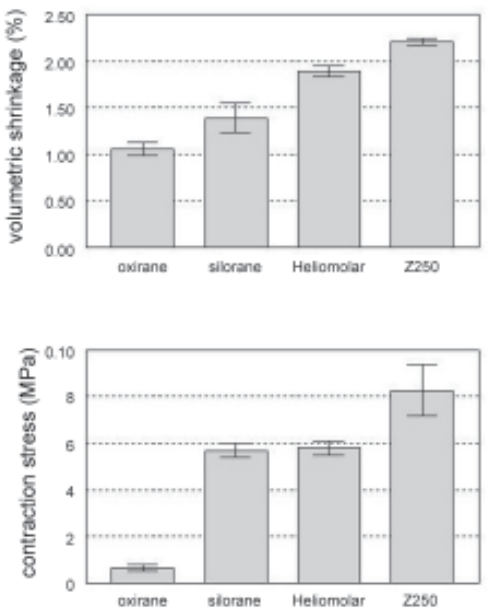
FIGURE 2 - Volumetric shrinkage (top) and contraction stress (bottom) of an oxirane- and a silorane-based composite compared to two commercial